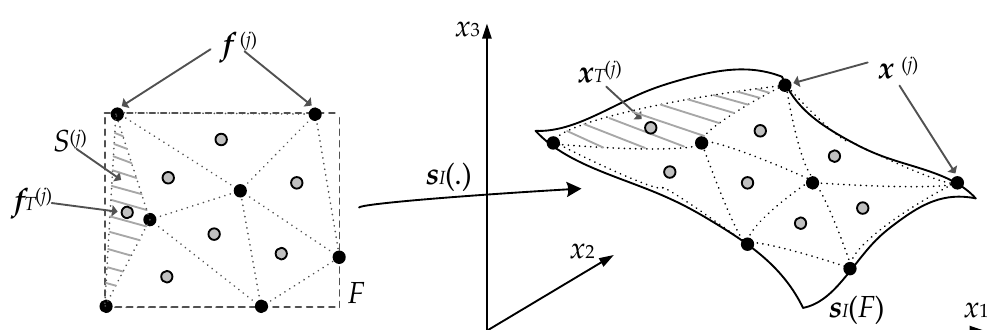
Figure 4. Triangulation of the reference designs performed in the objective space. The centers f T ( j ) of the resulting simplexes S ( j ) are mapped into the parameter space as x T ( j ) = s I ( f T ( j ) ).